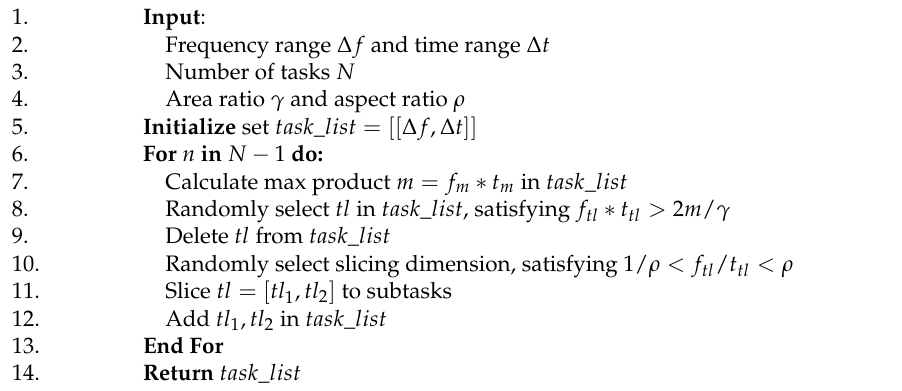
Table 4. Zero-waste satellite task list dataset